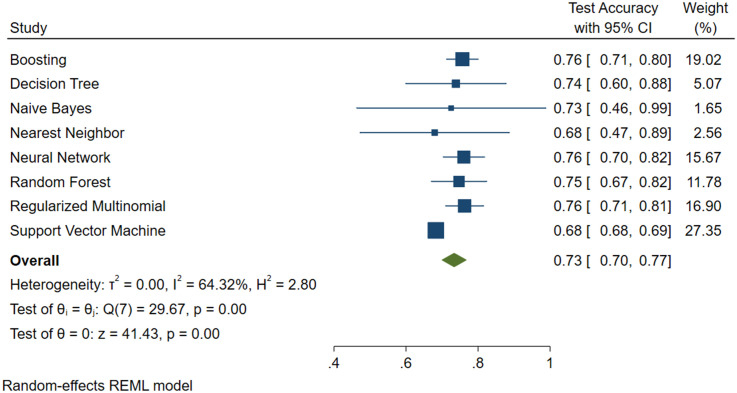
Machine learning applied to NAFLD diagnosis.Forest Plot for the FLI plus Glucose plus Age plus Sex Predictive Model.